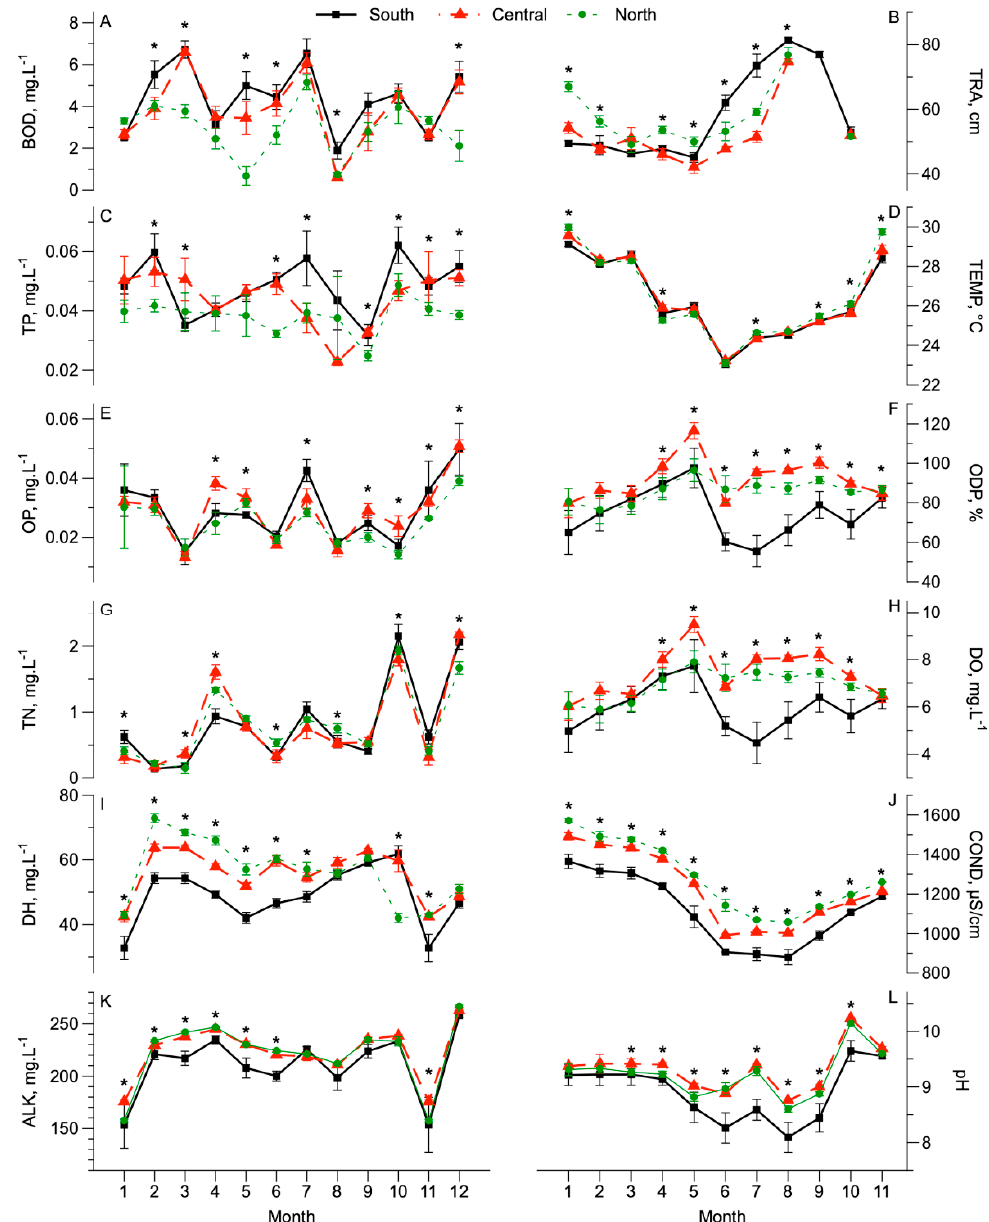
Figure 2. Physicochemical parameters of water in southern, central, and northern regions of Mãe-Bá Lagoon in (1) January, (2) February, (3) March, (4) April, (5) May, (6) June, (7) July, (8) August, (9) September, (10) October, (11) November, and (12) December. * Tukey’s test showed statistically significant differences between regions during each month ( p < 0.1).